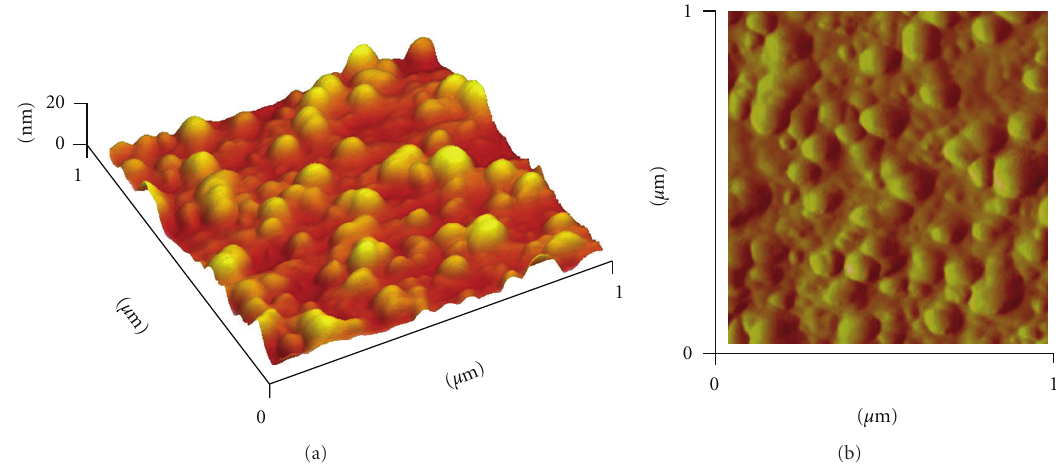
Figure 5: AFM images of biofunctionalized AgNPs embedded in organic moiety.